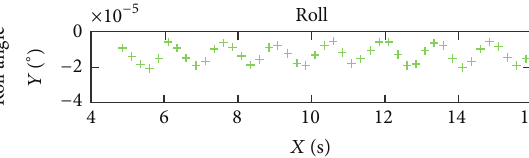
Figure 5: The attitude angle (Yaw) curve in 10